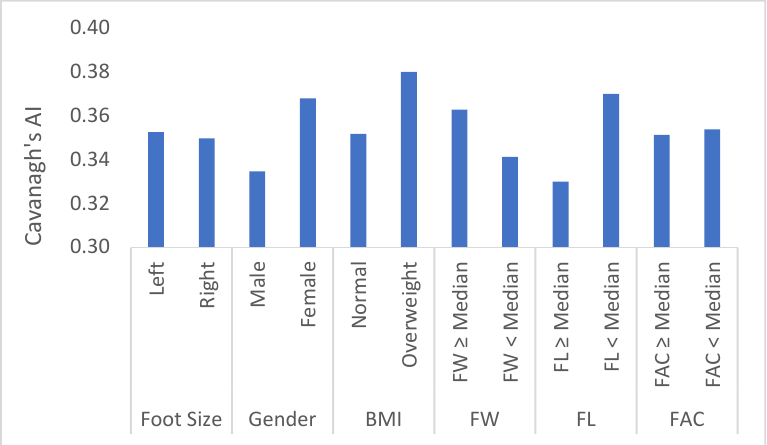
Figure 4. The correlation between the foot size, gender, BMI, and foot dimension parameter to the average AI.